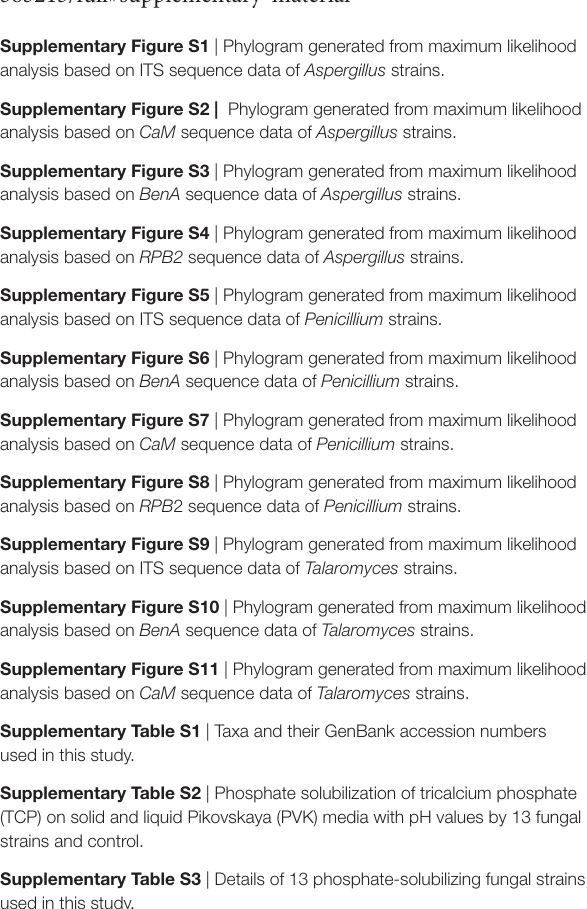
Supplementary Figure S1 | Phylogram generated from maximum likelihood analysis based on ITS sequence data of Aspergillus strains. Supplementary Figure S2 | Phylogram generated from maximum likelihood analysis based on CaM sequence data of Aspergillus strains. Supplementary Figure S3 | Phylogram generated from maximum likelihood analysis based on BenA sequence data of Aspergillus strains. Supplementary Figure S4 | Phylogram generated from maximum likelihood analysis based on RPB2 sequence data of Aspergillus strains. Supplementary Figure S5 | Phylogram generated from maximum likelihood analysis based on ITS sequence data of Penicillium strains. Supplementary Figure S6 | Phylogram generated from maximum likelihood analysis based on BenA sequence data of Penicillium strains. Supplementary Figure S7 | Phylogram generated from maximum likelihood analysis based on CaM sequence data of Penicillium strains. Supplementary Figure S8 | Phylogram generated from maximum likelihood analysis based on RPB 2 sequence data of Penicillium strains. Supplementary Figure S9 | Phylogram generated from maximum likelihood analysis based on ITS sequence data of Talaromyces strains. Supplementary Figure S10 | Phylogram generated from maximum likelihood analysis based on BenA sequence data of Talaromyces strains. Supplementary Figure S11 | Phylogram generated from maximum likelihood analysis based on CaM sequence data of Talaromyces strains. Supplementary Table S1 | Taxa and their GenBank accession numbers used in this study. Supplementary Table S2 | Phosphate solubilization of tricalcium phosphate (TCP) on solid and liquid Pikovskaya (PVK) media with pH values by 13 fungal strains and control. Supplementary Table S3 | Details of 13 phosphate-solubilizing fungal strains used in this study. Supplementary Table S4 | Nucleotide comparison of ITS, BenA , CaM, and RPB2 between strains of Penicillium guaibinense and P. austrosinense . Supplementary Table S5 | List of phosphate-solubilizing